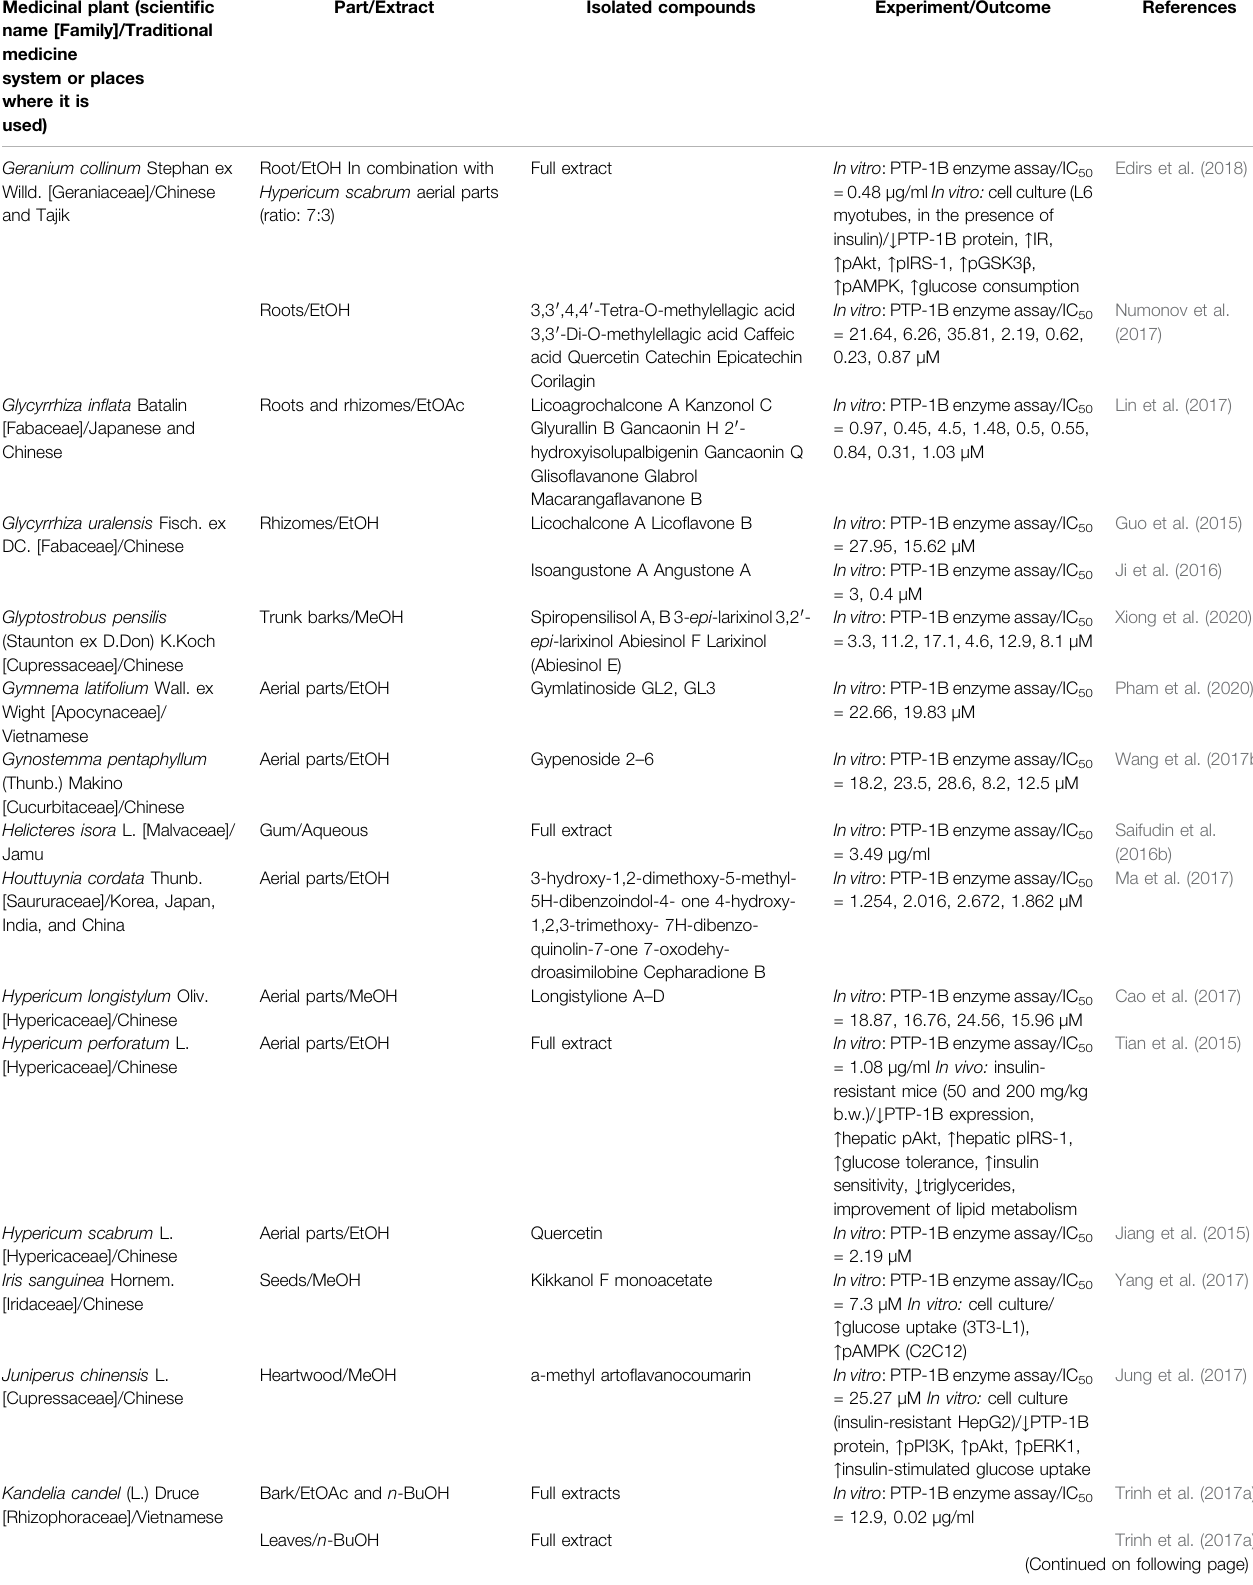
Medicinal plant (scienti fi c name